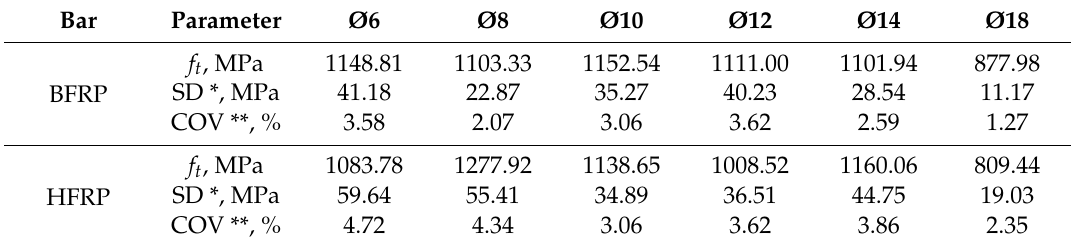
Table 2. Tensile strength results of FRP bars.